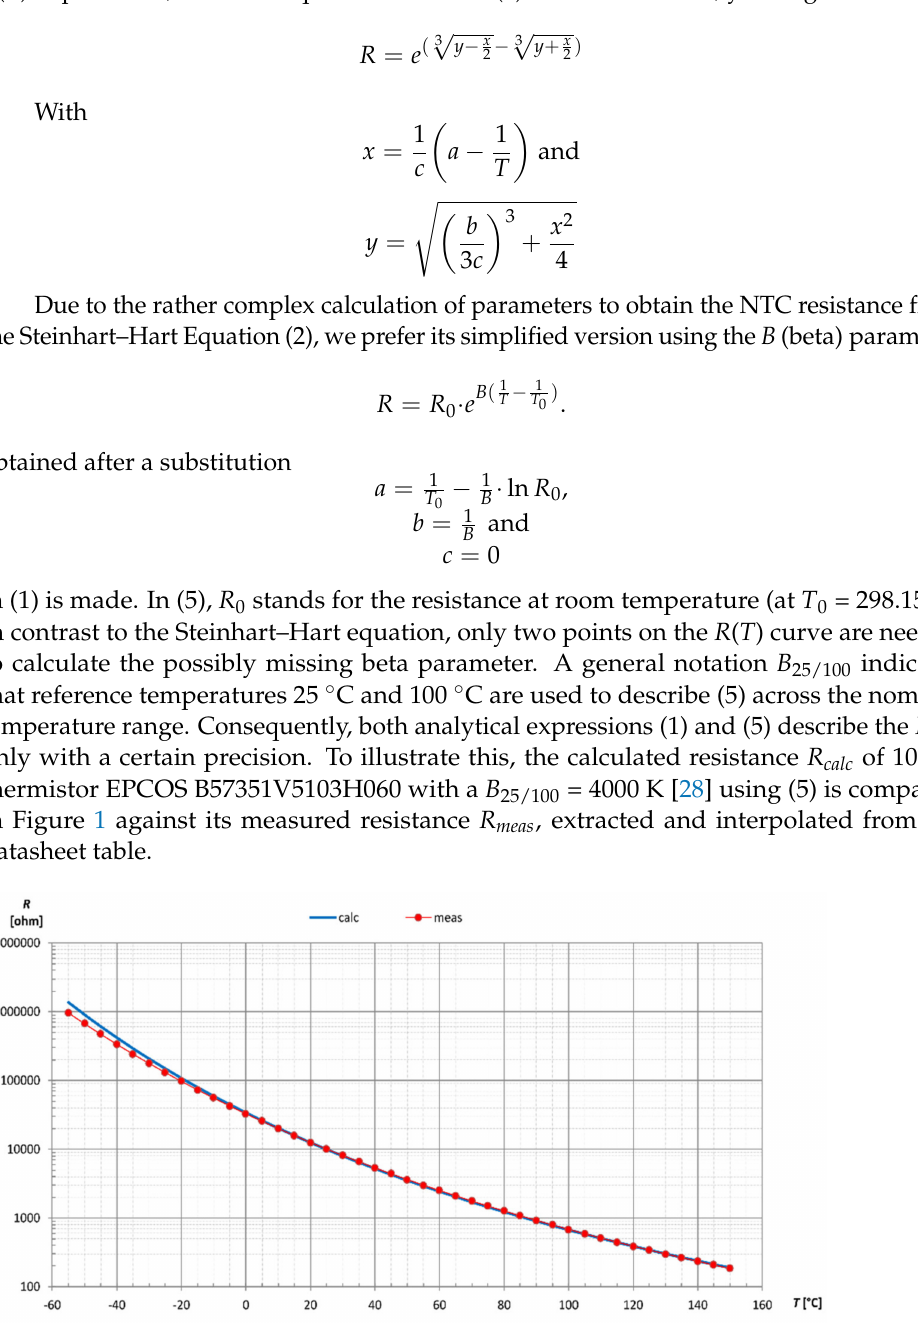
Figure 1. Calculated and measured resistance of 10 kohm NTC thermistor (logarithmic